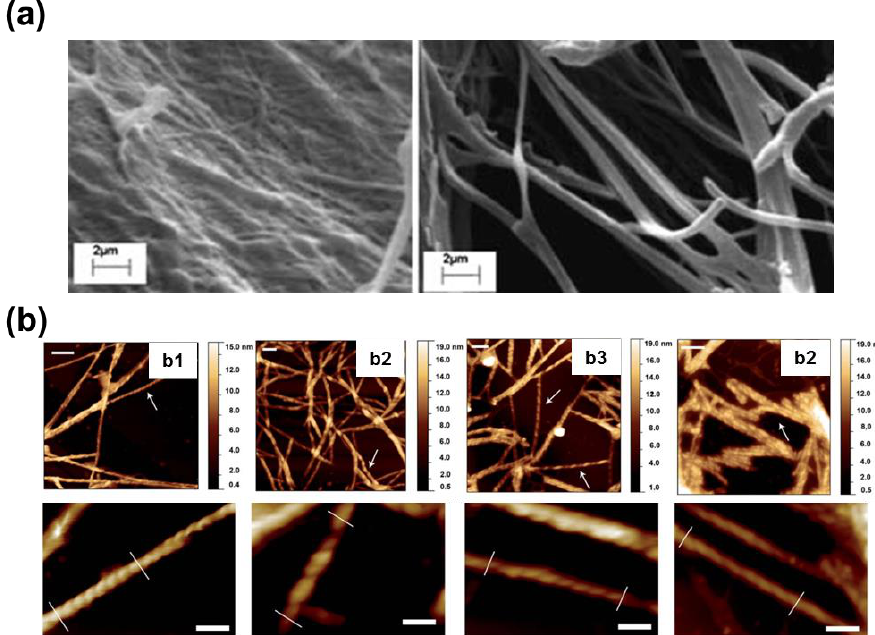
Figure 9. ( a ) SEM micrographs of dried Fmoc-FFF hydrogels obtained at moderate peptide concentration (1.36 mg/mL). Taken with permission from [48]. ( b ) AFM height images (scale bar: 100 nm) of Fmoc-FFF made of all-L (b1), all-D (b2), LDD (b3) and DLL (b4) amino acids. Arrows indicate fibers where twisting